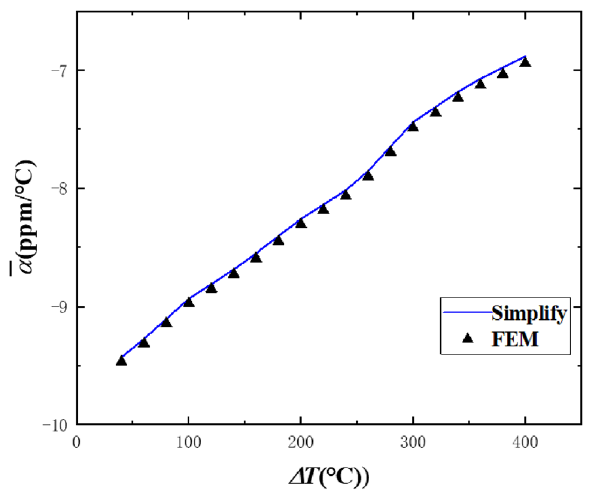
Figure 9. Comparison between theoretical formula and finite element method of nonlinear CTE.